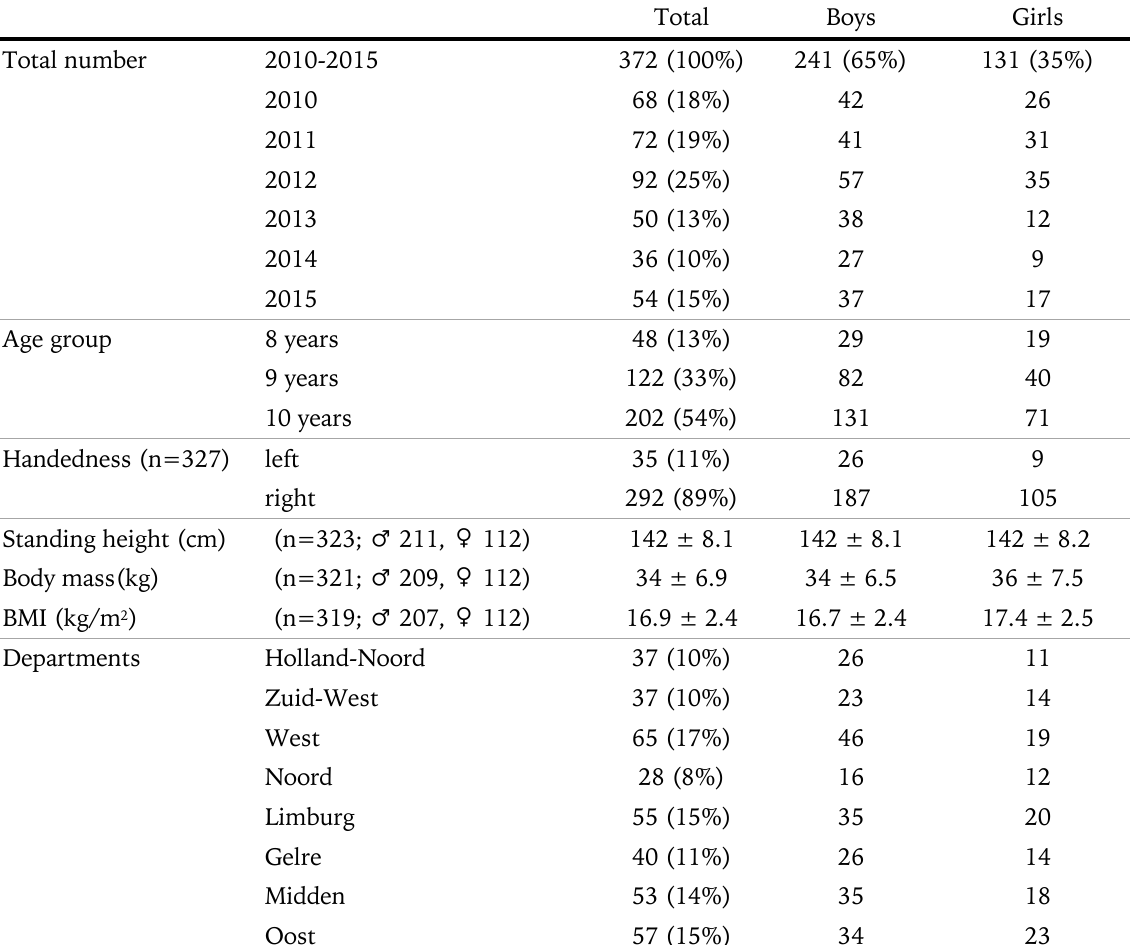
Table 2. Characteristics of participants